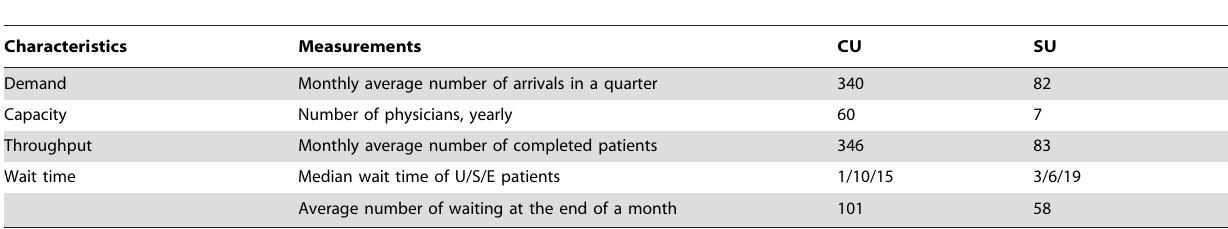
Table 3. A summary of the secondary data used in this study.